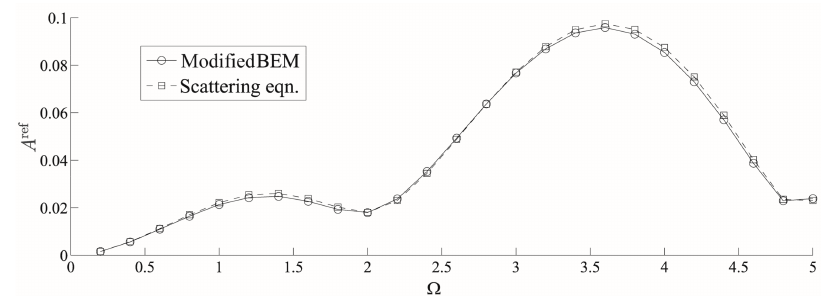
Figure 8. Reflection amplitudes obtained by BEM and half-space scattering equation